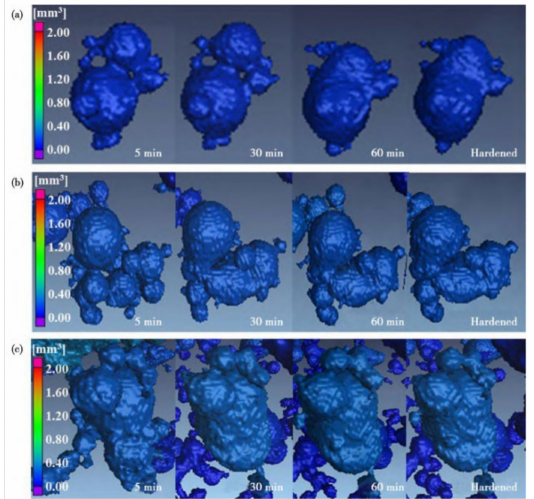
Figure 4. CT 3D reconstruction of bubble coalescence in concrete mortar. ( a ) Ref ( b ) Ether-type PCE with super-length side chains ( c ) Ester-type PCE with super-length side